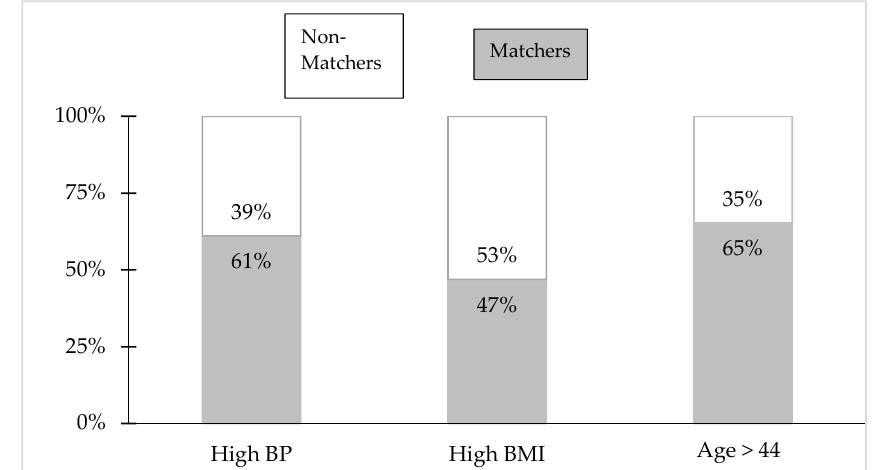
Figure 2. Comparison of those who match cluster profiles (Matchers) vs. those who do not (Non-Matchers), along the three best biological predictors of diabetes. Best predictors based on the recursive partition analysis. BMI—body mass index; BP—blood pressure; population weighted data.